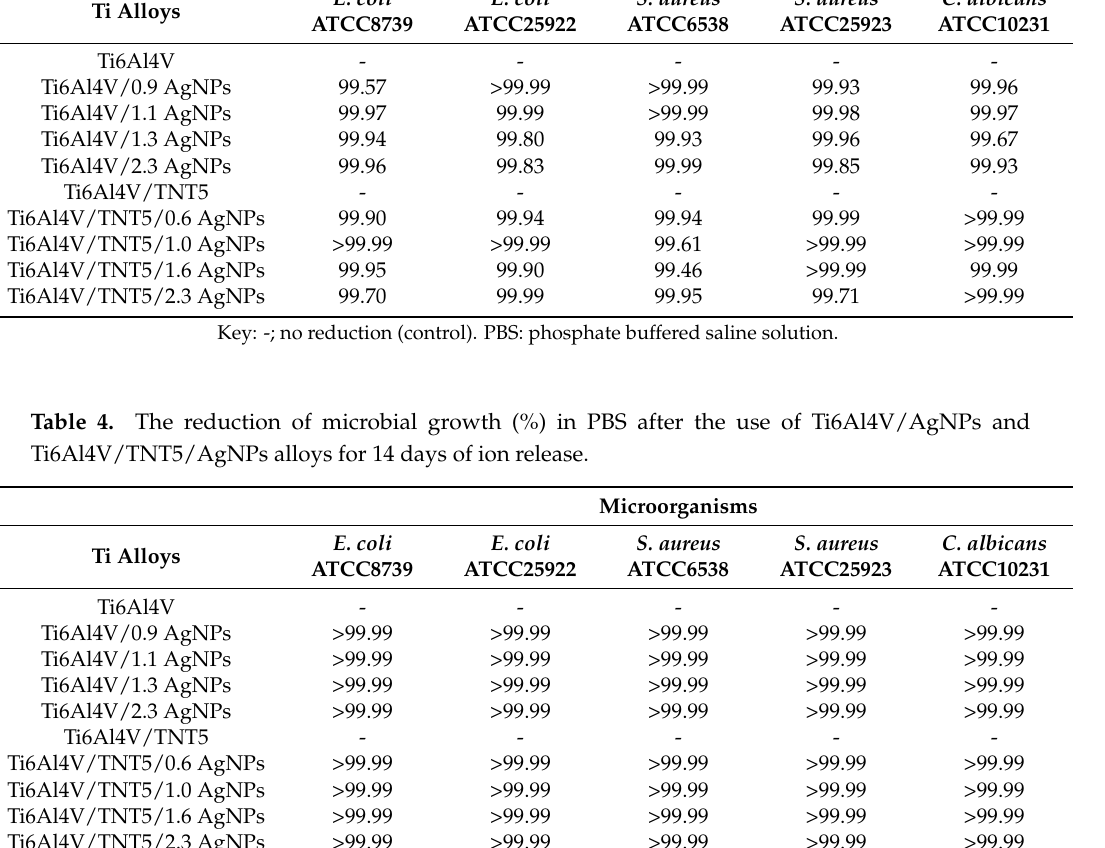
Table 3. The reduction of microbial growth (%) in PBS after the use of Ti6Al4V/AgNPs and Ti6Al4V/TNT5/AgNPs alloys for 24 h of ion release.